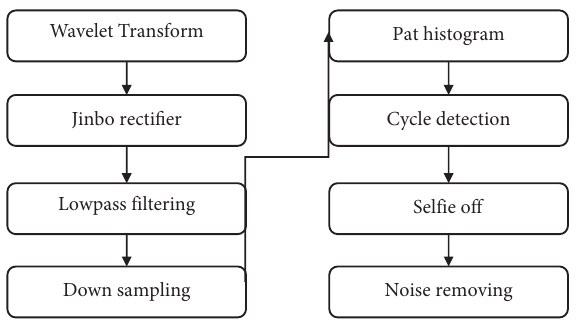
Figure 3: The calculation of the